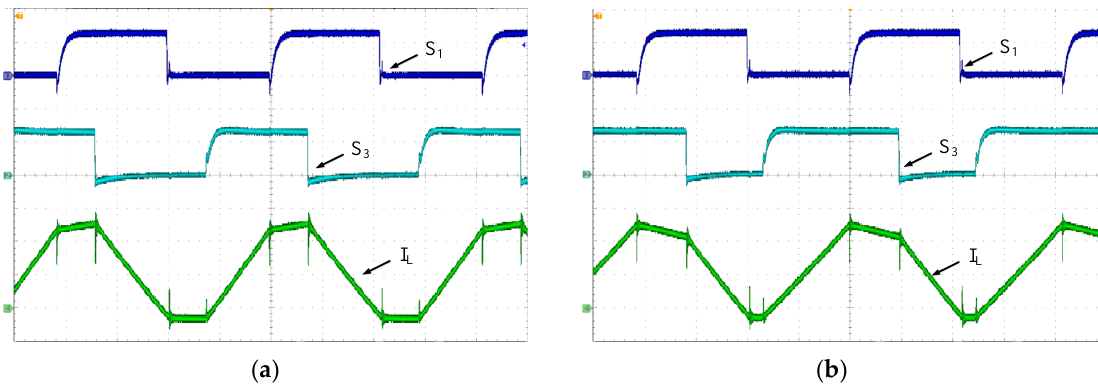
Figure 15. Measured waveforms under discharging mode (300 W). ( a ) Buck-discharging mode; ( b ) Boost-discharging mode. (CH1: 10 V/div, CH2: 10 V/div, CH4: 1 A/div, Time: 8 µ s/div).